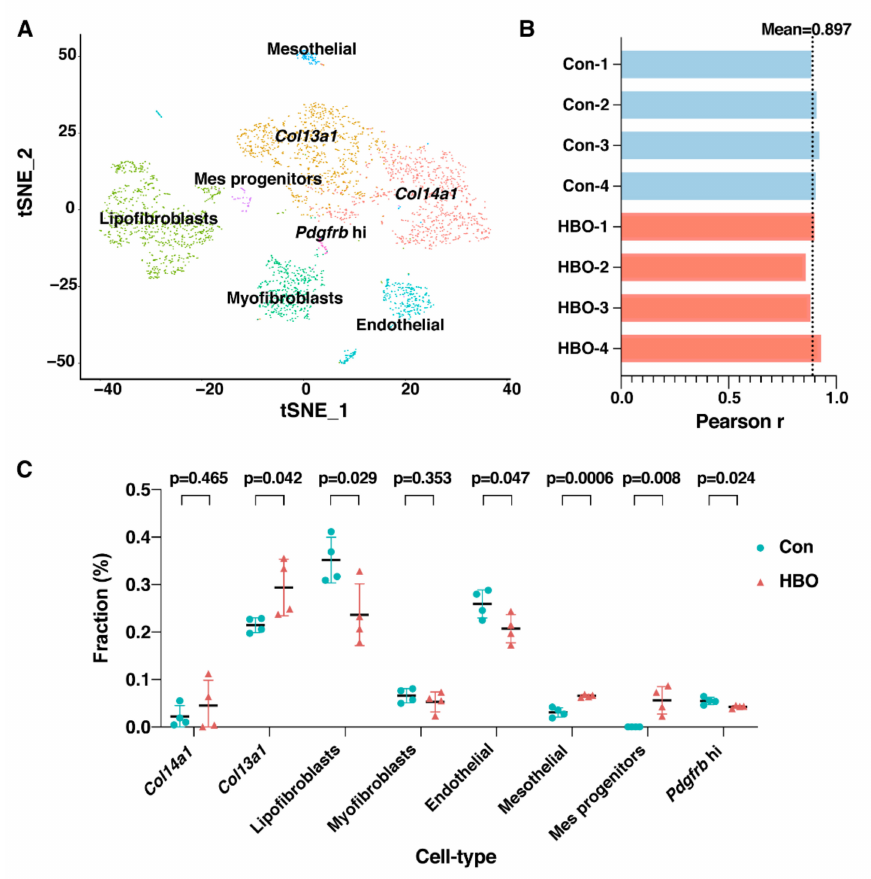
Figure 4. Repetitive HBO exposure a ff ected the composition of the 8 mesenchymal cell subtypes. ( A ) t-distributed stochastic neighborhood embedding (t-SNE) projection plot of the fibrotic mouse lung scRNA-seq data [32]. Di ff erent colors indicate di ff erent clusters, as indicated by text over each cluster. Eight clusters were identified. ( B ) Bar plot represented Pearson correlation coe ffi cients, for control (blue) and HBO-treated (red) mice, between our RNA-seq data and the scRNA-seq data. Black dotted line indicated the mean Pearson correlation coe ffi cients across all samples. ( C ) Comparisons of the ratios of the 8 mesenchymal cell types in control (blue) and HBO-treated (red) groups. Y -axis indicates the fraction of each cell type, X -axis are the eight cell types. Error bars represent standard